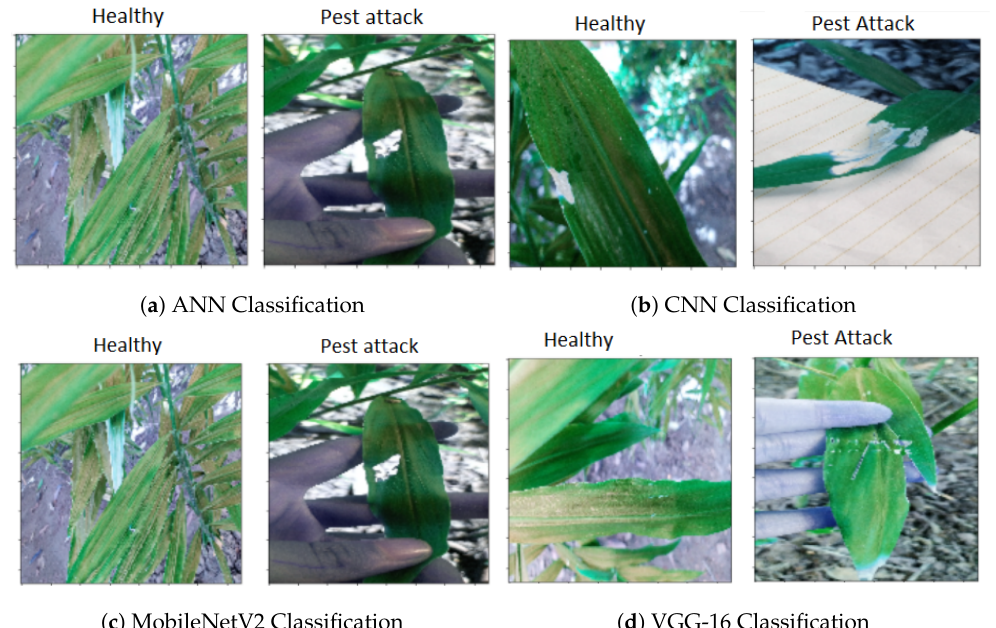
Figure 7. Testing of models on pest pattern classification.